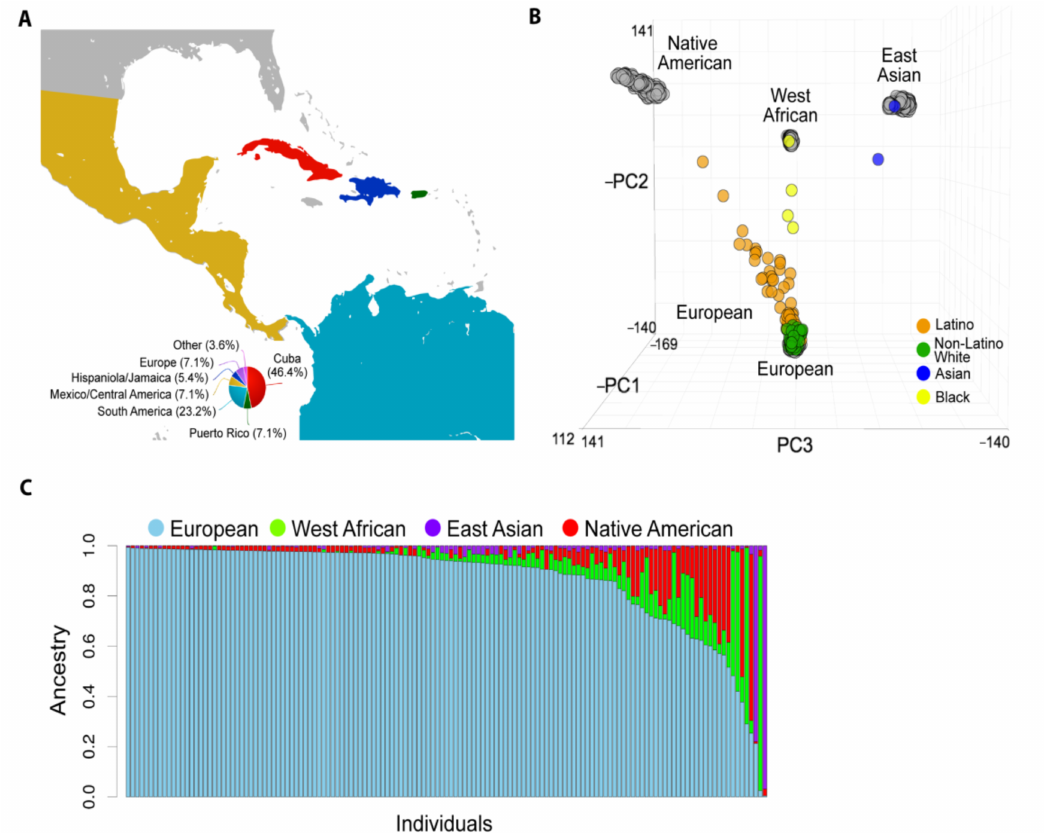
Figure 1. Population structure of studied patients with uveal melanoma (UM). ( A ) The global catchment area of our patient cohort. The smaller pie chart indicates patients born outside of the United States. ( B ) Principal component analysis (PCA) based on approximately 100 K variant loci in common across 141 UM patients (colored circles) and the global ancestry reference panel populations (grey circles). ( C ) Unsupervised clustering of ADMIXTURE algorithm analysis of our cohort assuming K = 4 ancestral clusters. Each stacked column represents an individual patient, and the height of each stacked column represents the contribution of each indicated ancestry to the overall genetic makeup of each